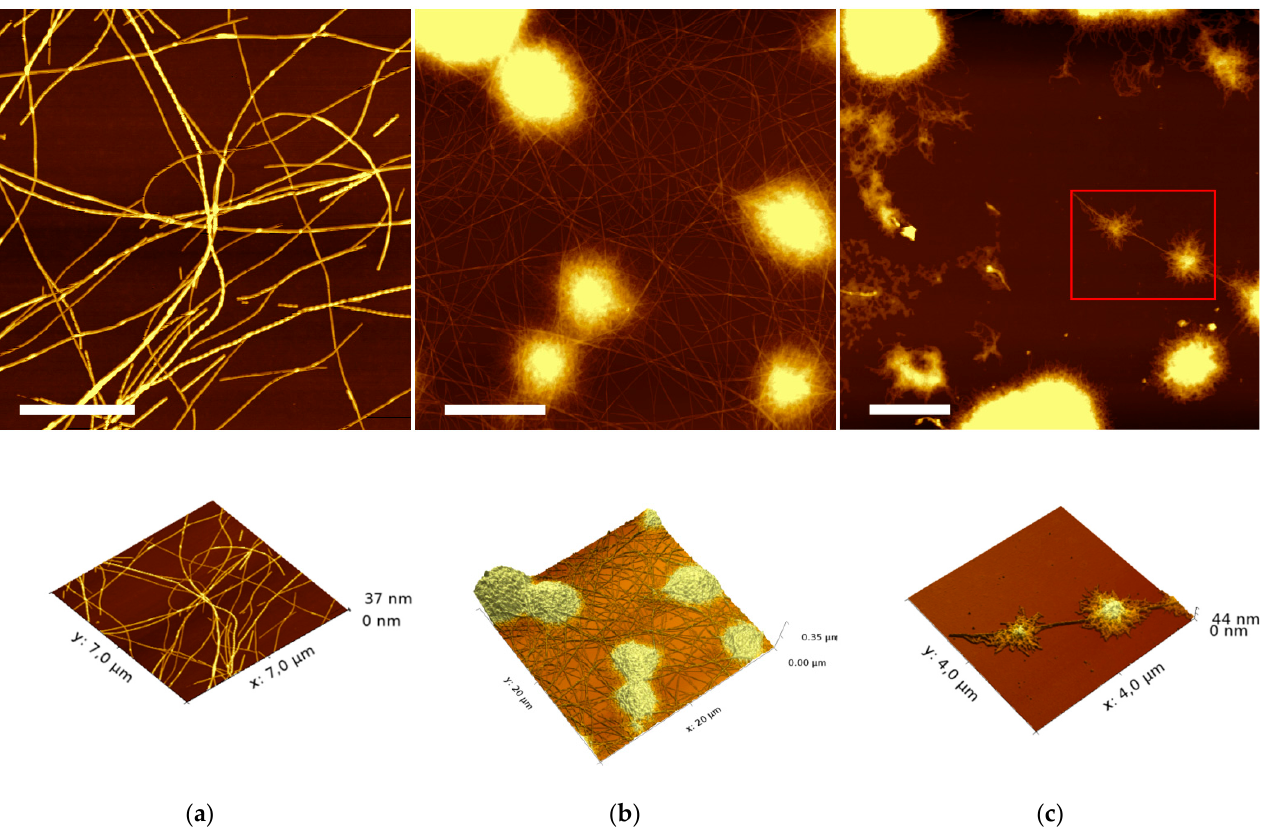
Figure 8. Schematic representation of the hydrogels obtained from assembly of P5 and P21 peptides. In yellow is the P21 peptide representation; in blue are the P5 fibrils. In the red circle, the schematic of P5:P21 (100:1) hydrogels is highlighted.